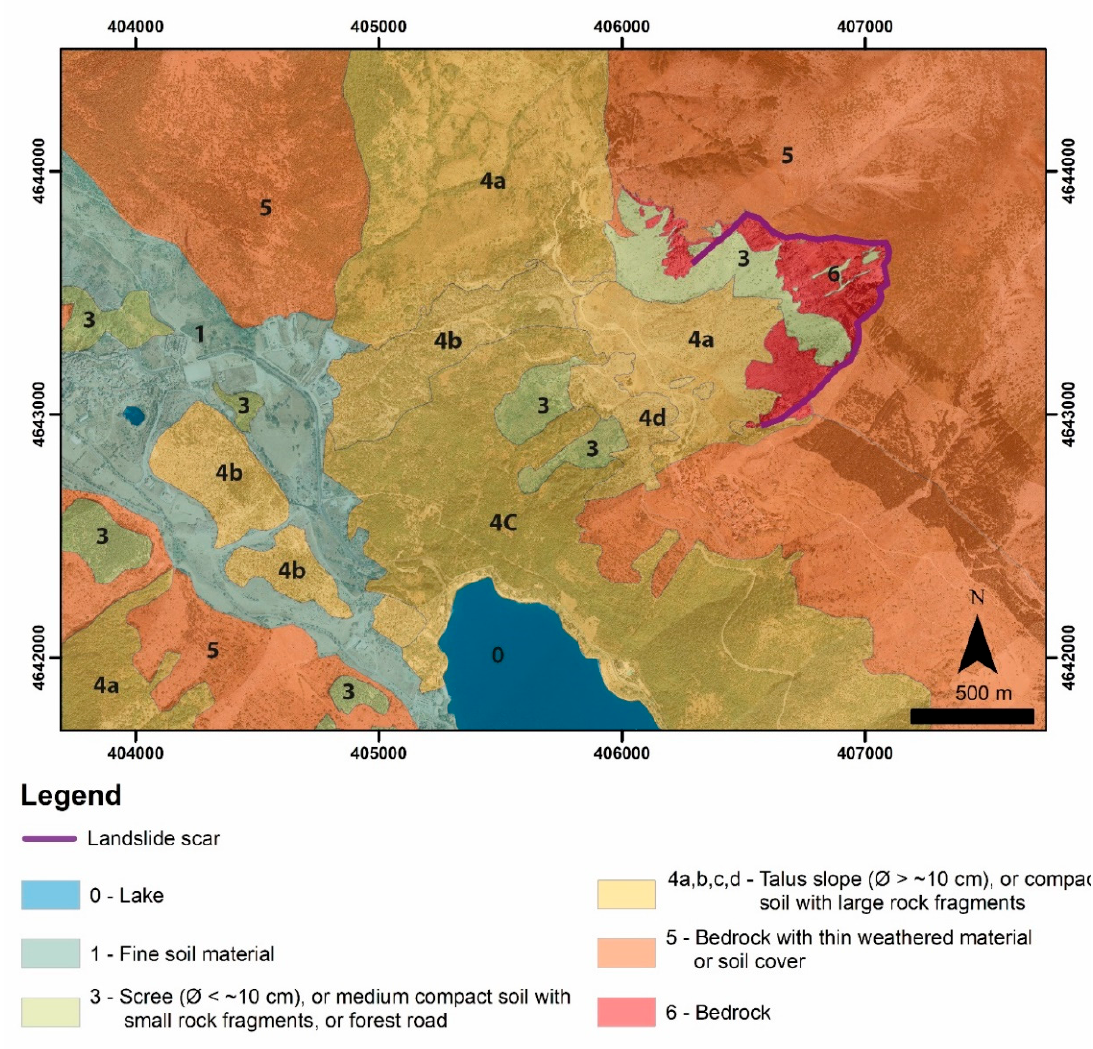
Figure 12. Map of soil types. Orthophotographs are used as base maps.